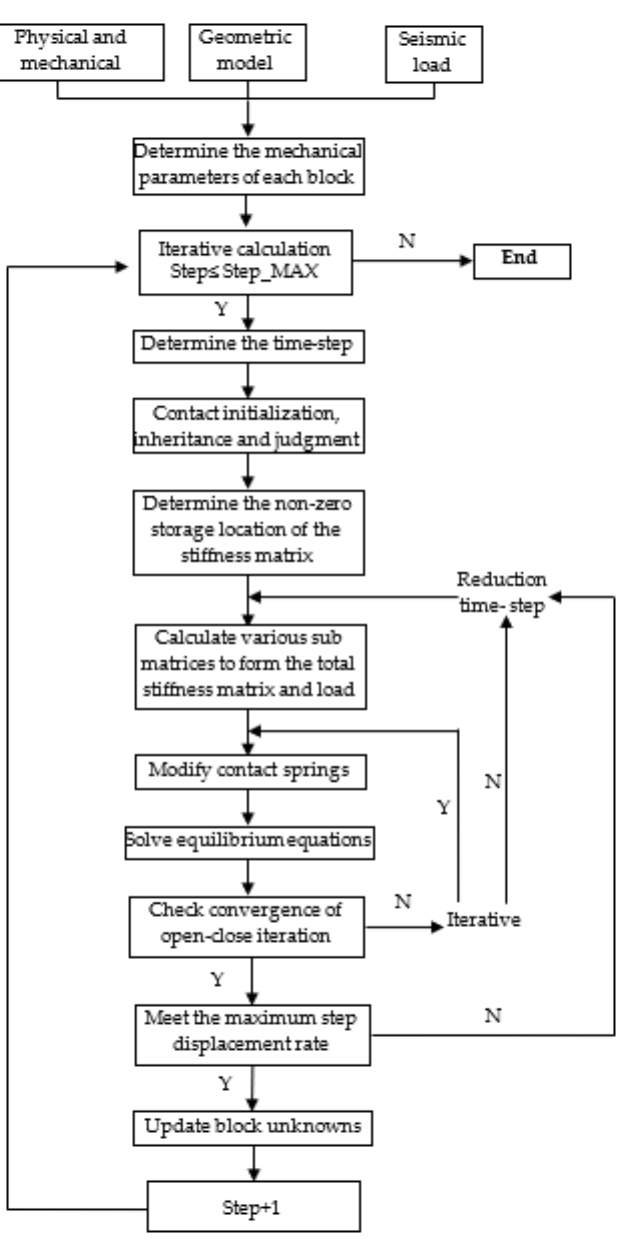
Figure 1. Analysis process of DF module of the DDA program.